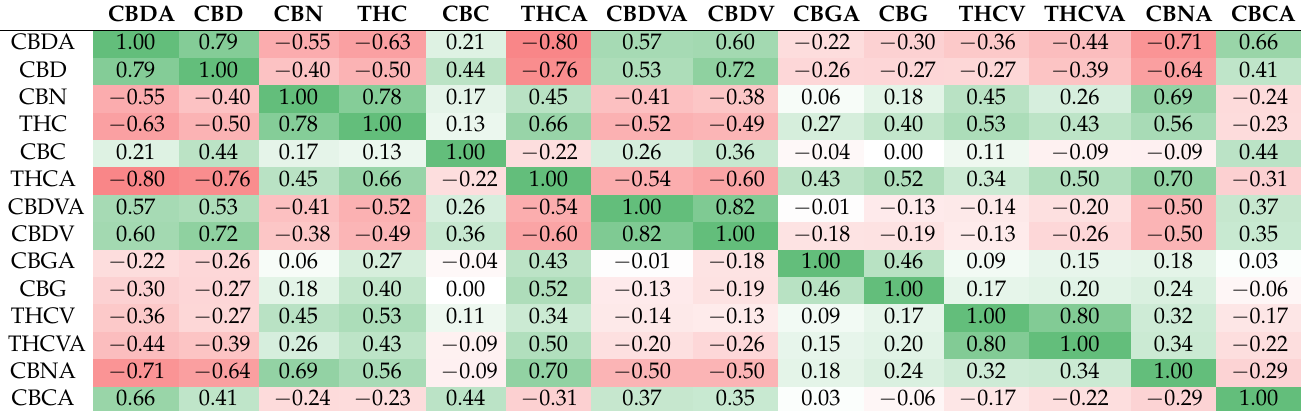
Table 5. Correlation matrix of 14 cannabinoids taken from all harvest